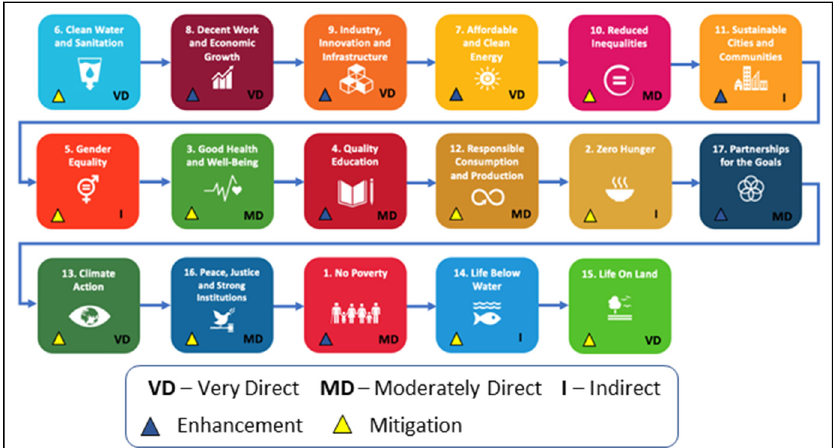
Figure 3. Ranking of the significance of SDGs for the RM sector by the Slovak stakeholder groups. The type of RM sector impact on the specific SDGs was codified based on EBRD [18].